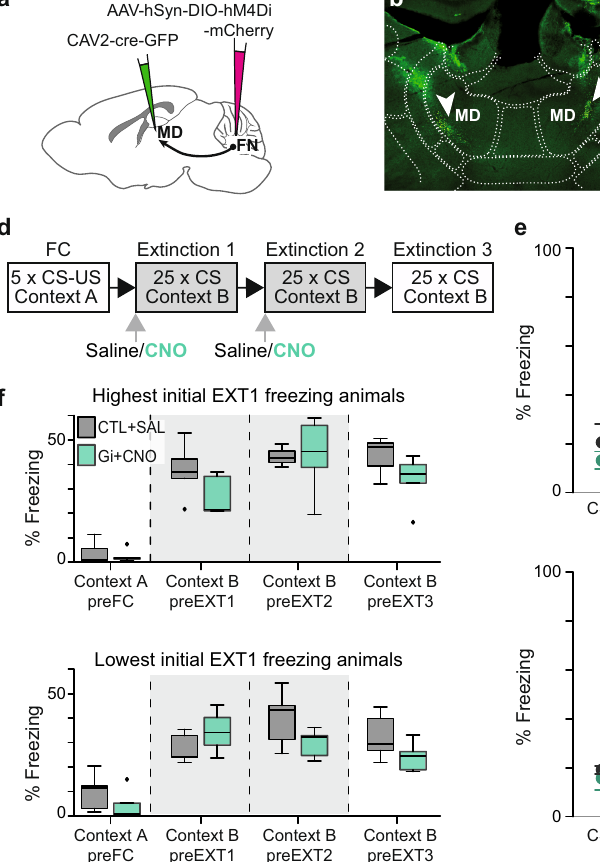
groups of same size expressing respectively the highest and lowest freezing levels on the Early stage of EXT 1. Lines represent mean±SEM. Post-hoc two-sided t -test Holm-Sidakcorrected,* p <0.05. f FN-MD chemogenetic inhibitionofFN-MD input did not affect basal levels of freezing during habituation to the context of fear conditioning (ContextA) or extinction (ContextB), compared to the control mice; same groups and statisticsas inpanel e . Boxplots represent quartiles and whiskers correspond to range; points are singled as outliers if they deviate more than 1.5 x interquartilerangefromthenearestquartile, p >0.05.Dataavailableatdoi:10.5061/ dryad.9kd51c5ng. Detailed statistical results are available in the Supplementary Tables referenced by panel